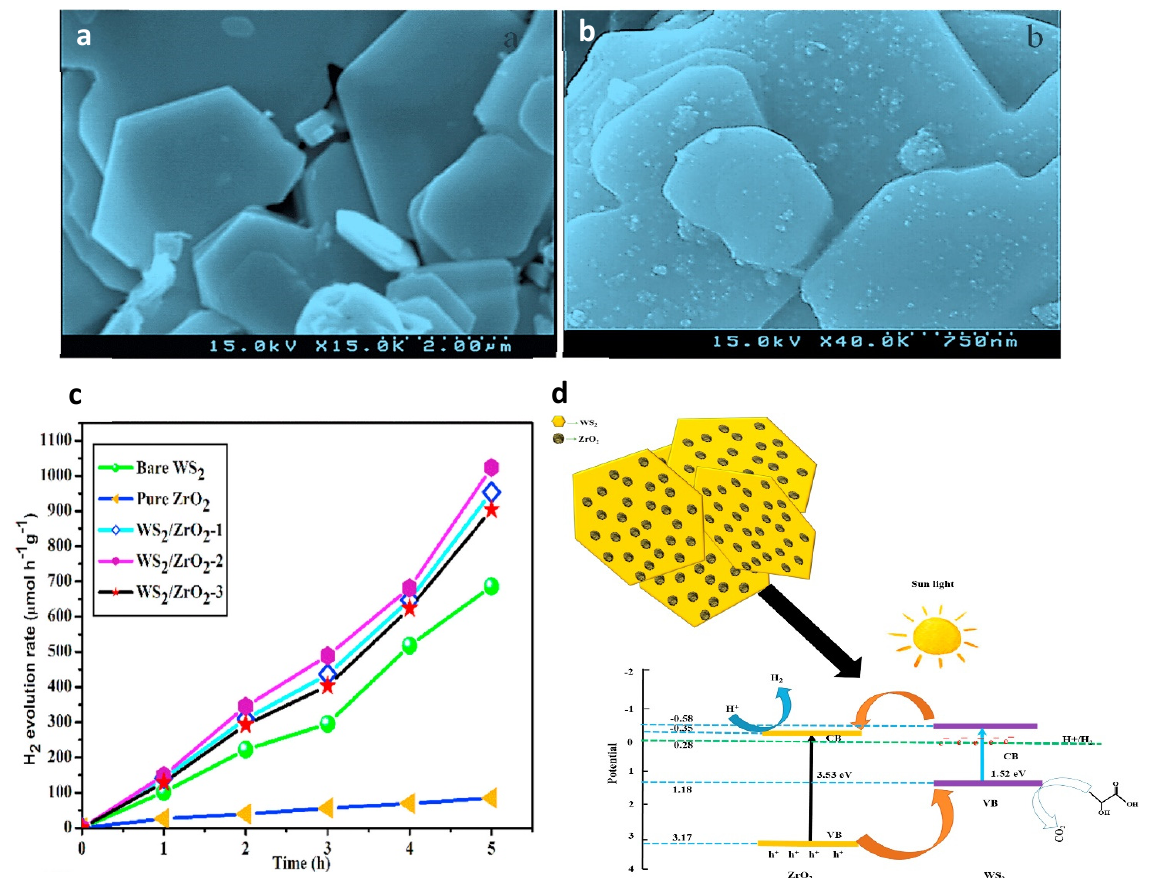
Figure 16. SEM images of ( a ) bare WS 2 and ( b ) WS 2 –ZrO 2 heterostructure. ( c ) Photocatalytic H 2 evolution under simulated solar light irradiation of the prepared catalysts. ( d ) Plausible photocatalytic mechanisms for WS 2 /ZrO 2 hybrid catalyst. Reproduced with permission. [151] Copyright 2019, Elsevier.